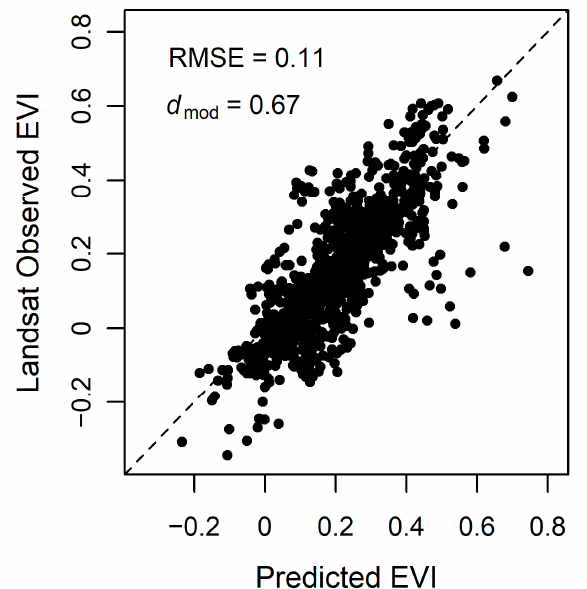
Figure 7. Predicted versus Landsat observed 2019 EVI from 95 random points throughout the Bay Area. The dashed line represents the 1:1 line of perfect agreement between predicted and observed values. Root mean square error (RMSE) = 0.11 and the modified Willmott’s index of agreement d mod = 0.67.